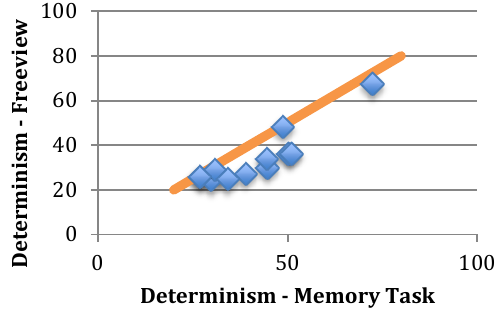
Figure 12 : Recurrence values for observers who free viewed twelve paintings of various complexity and abstraction relative to observers who were told that they would be asked questions about the content of the paintings . The line defines where recurrence for observers free viewing images would match those tasked with remembering the image